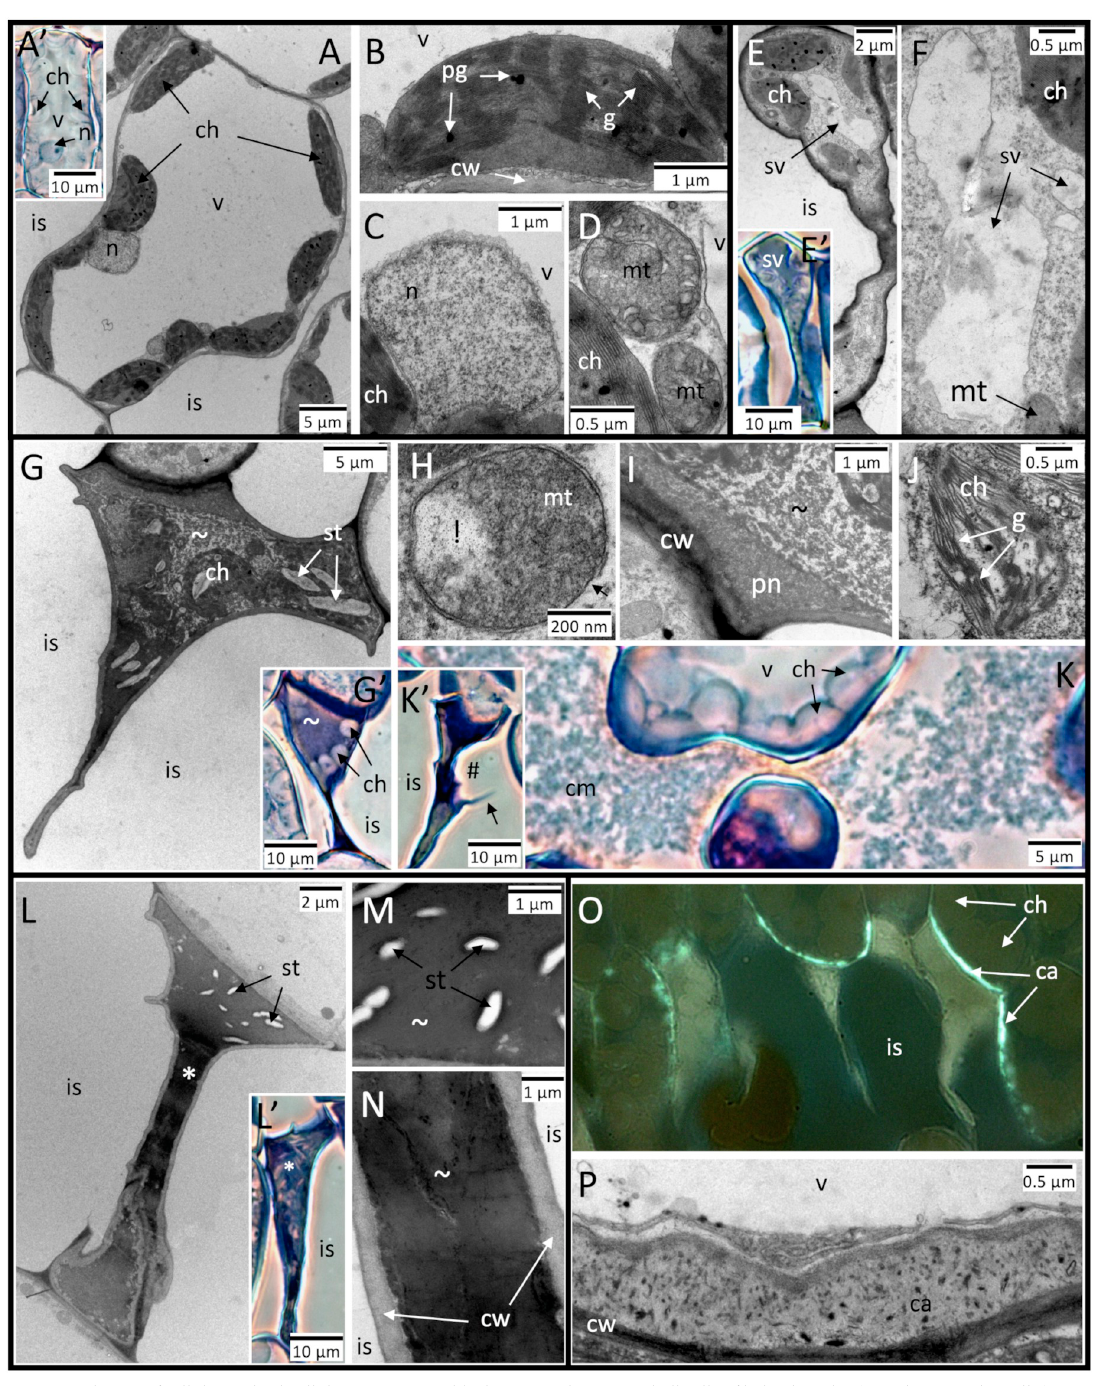
Fig 3. Evolution of cellular and subcellular traits in HR-like lesions within mesophyll cells of hybrid poplar ( Populus tremula x alba ) leaves at the 3 rd (A–D, K–P) and 10 th leaf position (E–J) and in response to the CF+100 ppb O 3 treatment. A – D Asymptomatic mesophyll cell structure in the CF treatment. E – F Early stage of HR-like reaction development: cell death and cytorrhysis. In apparent relation to cell cytorrhysis, the vacuole was shrunken (sv) and its irregular shape indicated tonoplast rupture, whereas other organelles were still intact. G – K Intermediate stage of HR-like reaction development: disruption of cell content. H Within mitochondria, degradation of the mitochondrial matrix (!) and disruption of outer membrane (arrow). I Nucleus pyknosis (pn) and condensation of cytoplasm (~). J chloroplast (ch) disruption. K–K’ Leakage of cell debris (cm) into the intercellular space (is) through break points in the cell wall (#). L – N Final stage of HR-like reaction development: condensation and fusion of cellular debris. O – P Local thickening of cell wall (cw) through callose deposition within cells adjacent to lesions. Other structures: g: grana, n: nucleus, v: vacuole. Technical specifications: